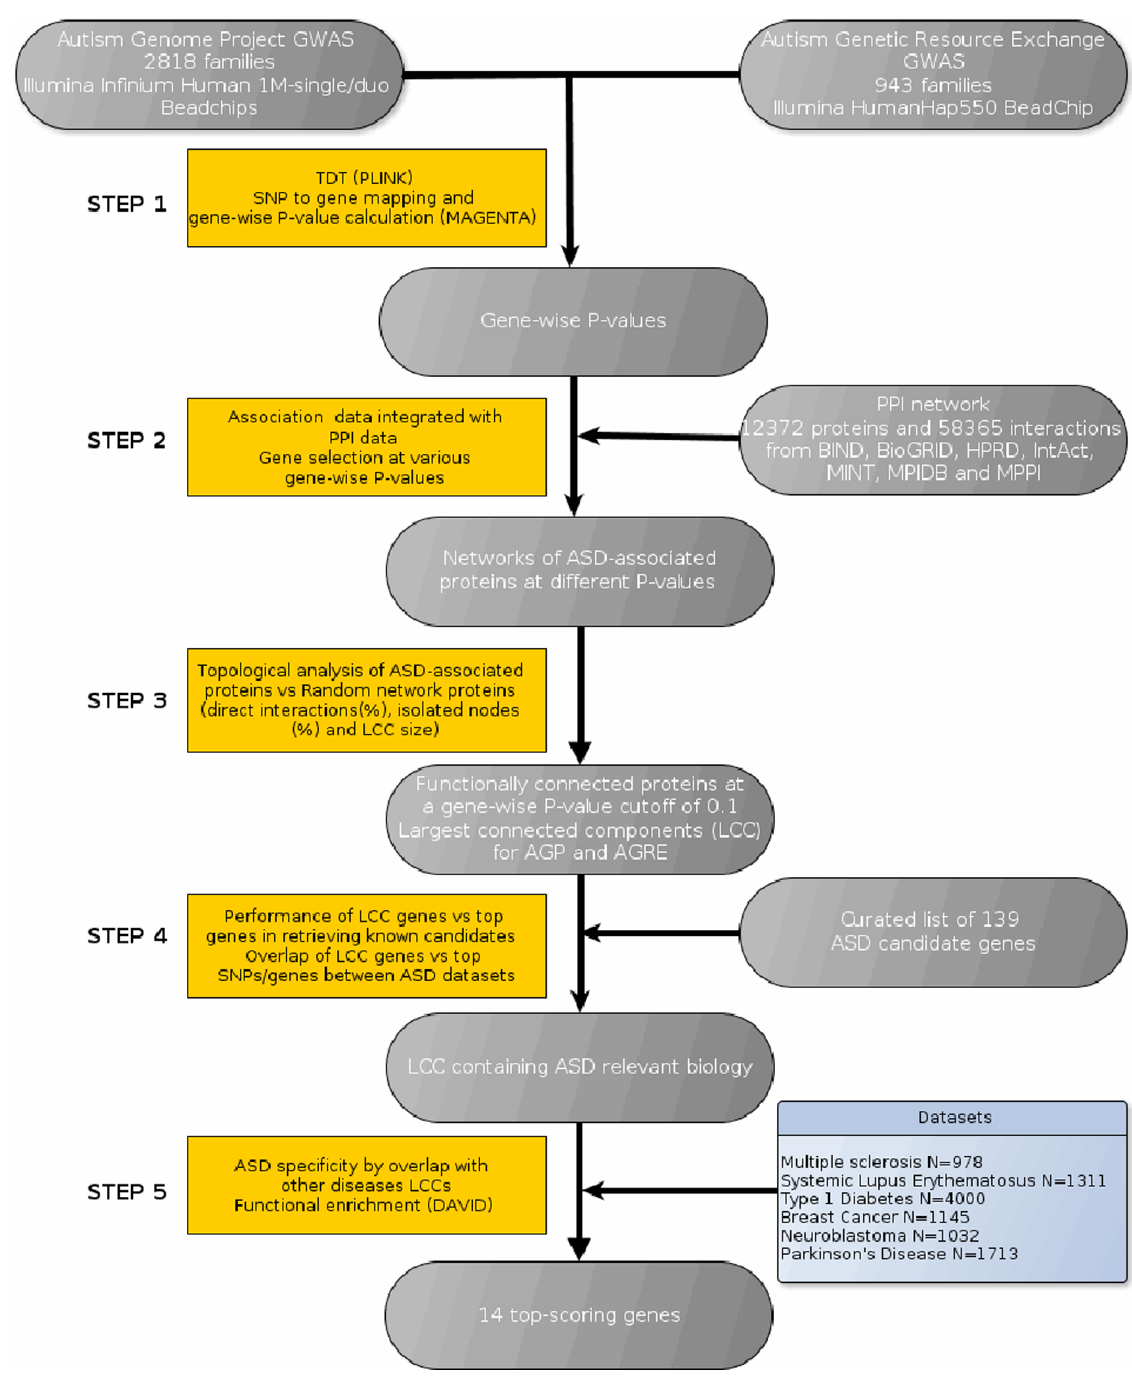
Figure 1. Workflow of the strategy for network definition, validation and identification of most relevant candidate genes.